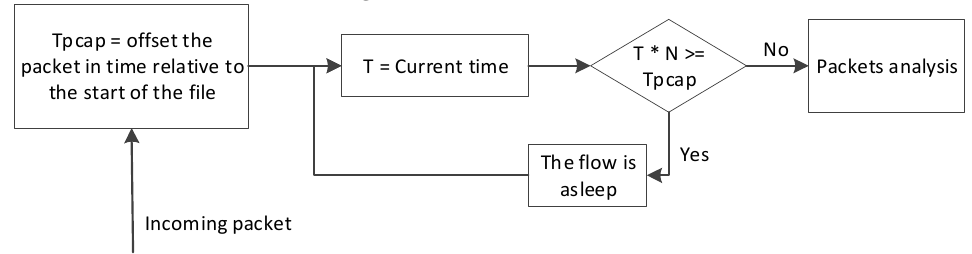
Figure 8. Algorithm for network packet capturing.